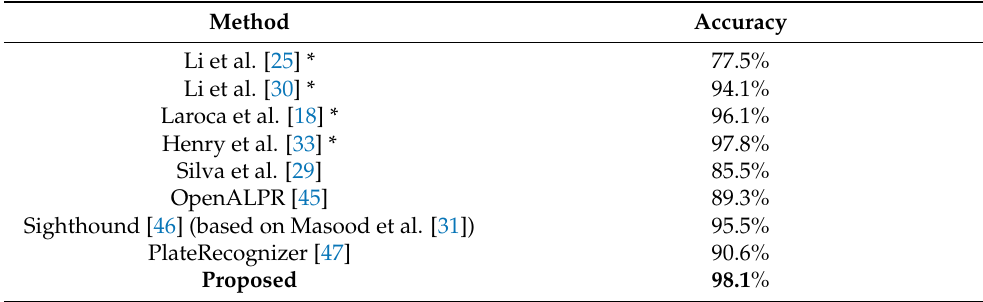
Table 3. Comparison of the proposed mobile ALPR system with the existing methods, using the Caltech benchmark dataset [43].